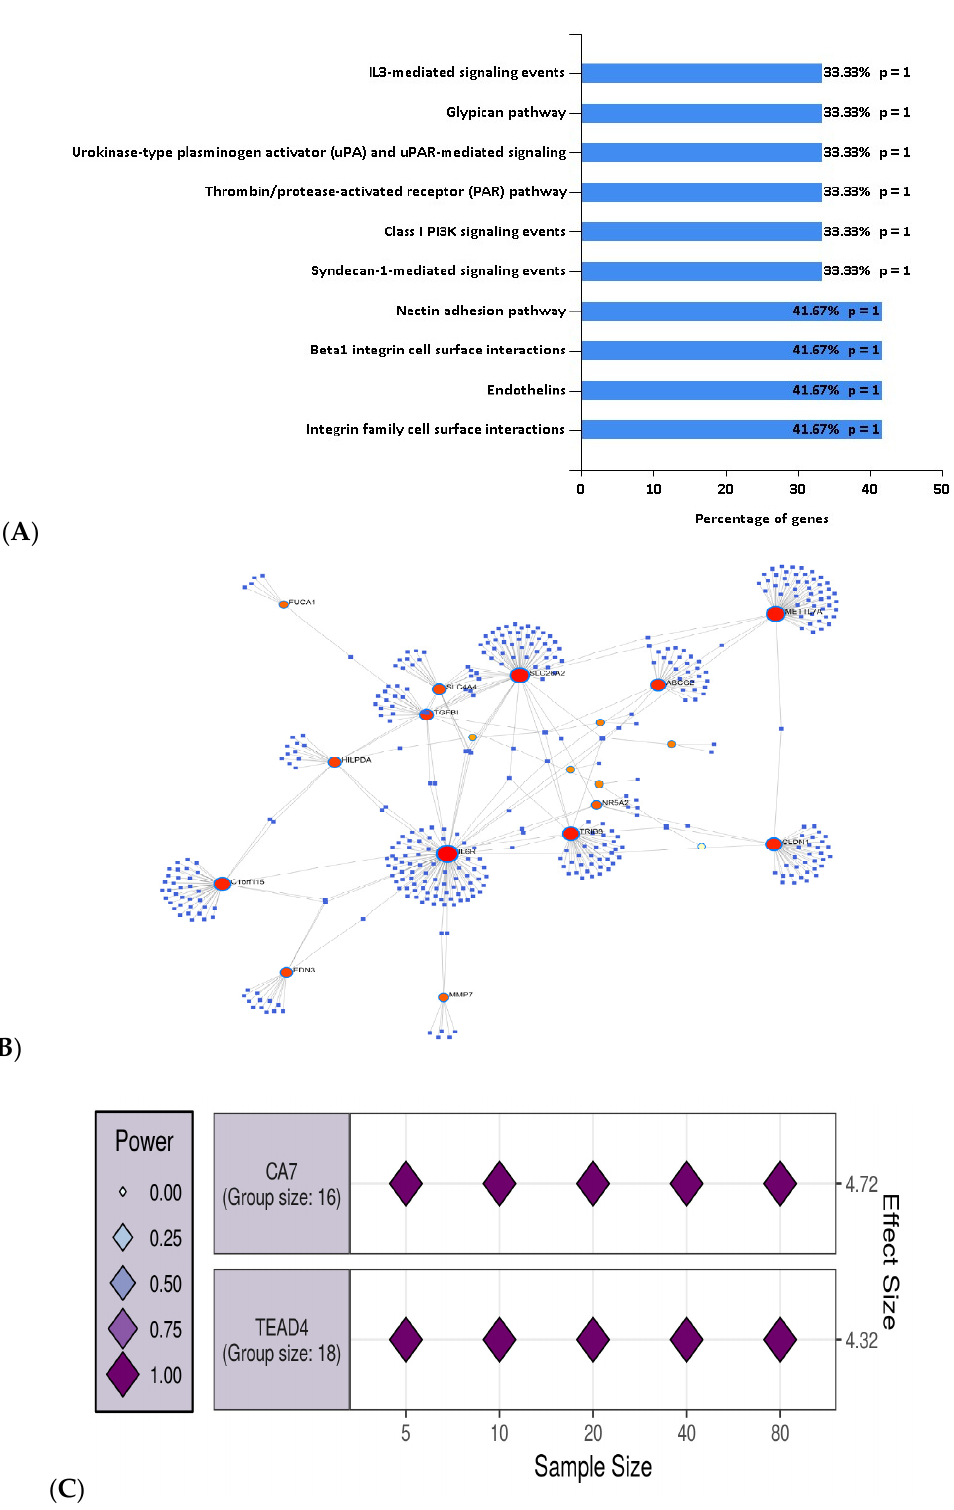
Figure 5. ( A ) Pathway enrichment analysis with the genes selected using the MDI method; ( B ) mapping of the 19 most interacting genes out of 34 genes with miRNAs and their interconnections; ( C ) the two clusters of genes with representative genes CA7 and TEAD4 for the GSE44861 are visualized by the largest effect size. The effect size of each assessed variable is shown along the y -axis, with a series of sample sizes along the x -axis.